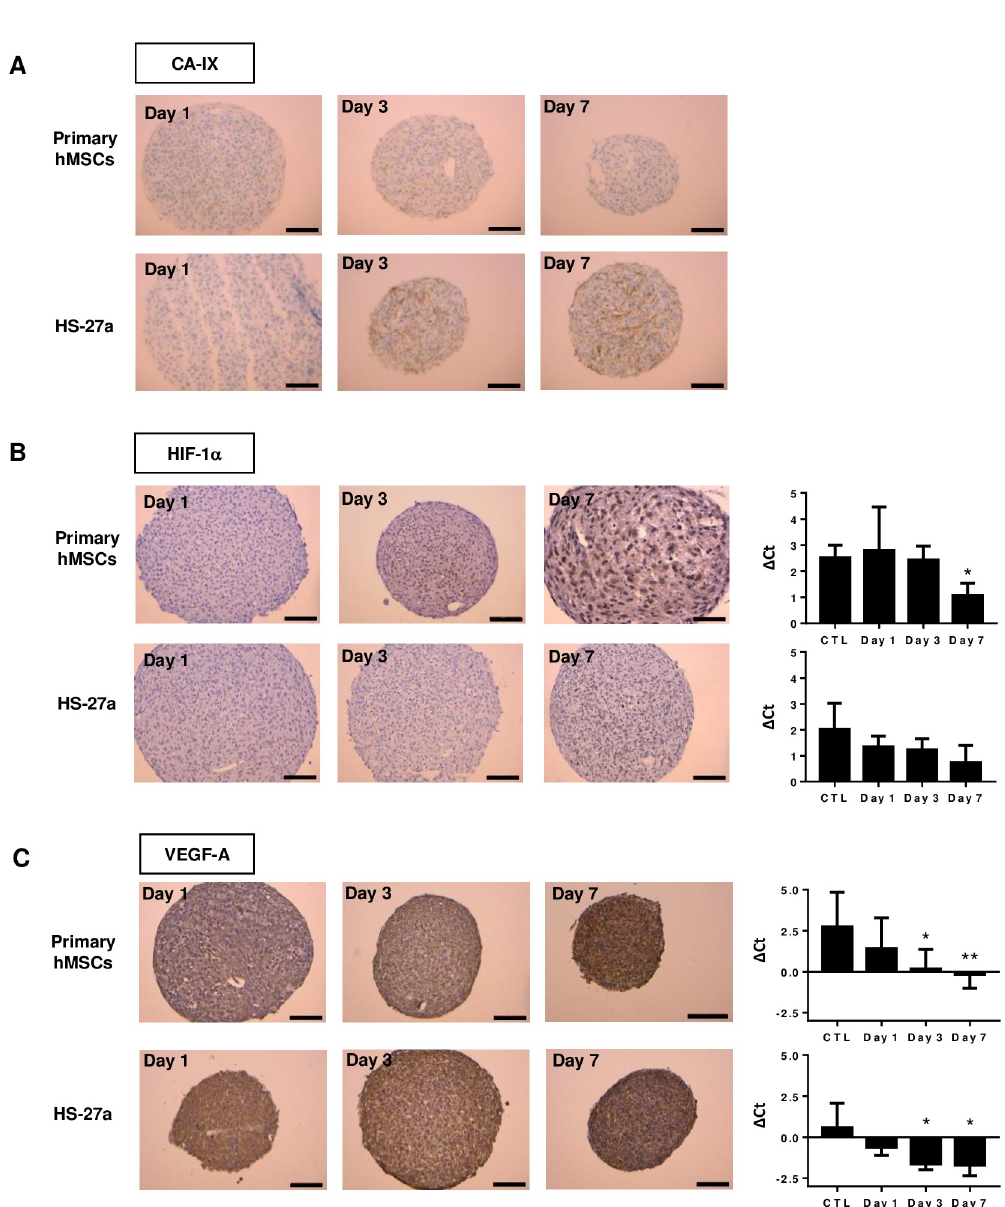
Fig 5. Hypoxia detection of primary hMSC- and HS-27a-spheroids over 7 days in culture. (A) Immunohistochemistry of CA-IX. (B) Immunohistochemistry and mRNA of HIF-1 α . (C) Immunohistochemistry and mRNA expression of VEGF-A. (primary hMSCs n = 5; HS-27a n = 3; � p � 0.05; �� p � 0.01; scale bars = 100 μ m).